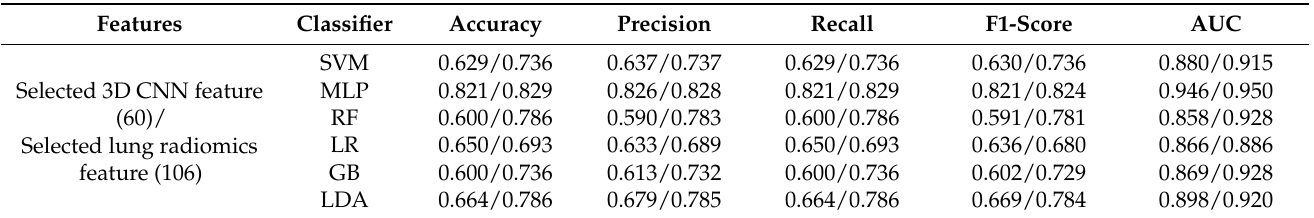
Table 3. The different ML classifiers’ performance on the test set of selected 3D CNN features (60) or lung radiomics features (106) generated by the Lasso algorithm in Experiment 1.